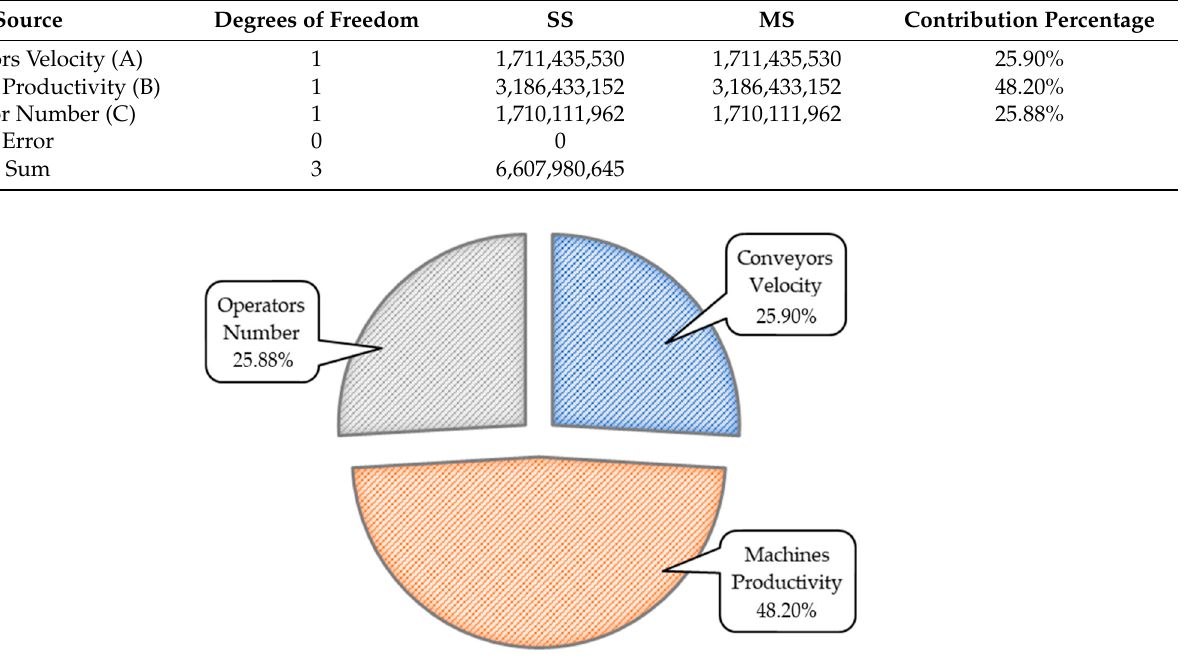
Figure 13. Contribution Analysis per Factor, based on ANOVA.